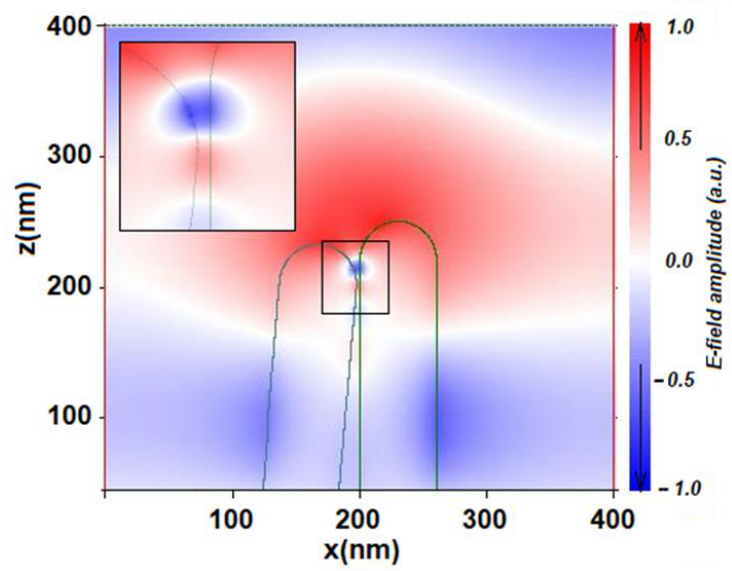
Figure 4. Formation of a propagating plasmon–polariton (alternating blue and red areas) near the space between two NW tips with a tilt angle of 5°.